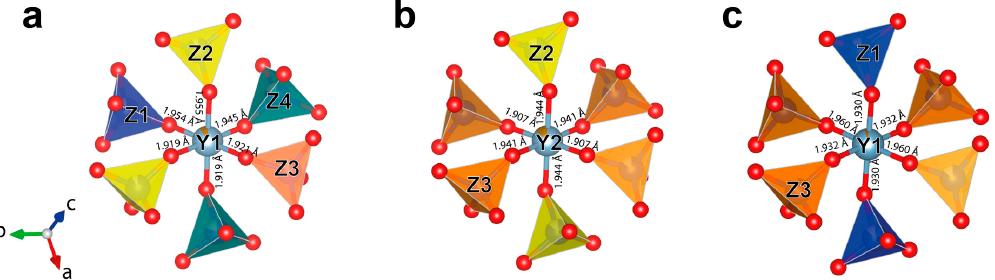
Figure 6. Bond lengths and environment of octahedral sites: Y1 site in I 42 d model ( a ); Y2 ( b ) and Y1 ( c ) sites in the I 4 1 / a structure model.